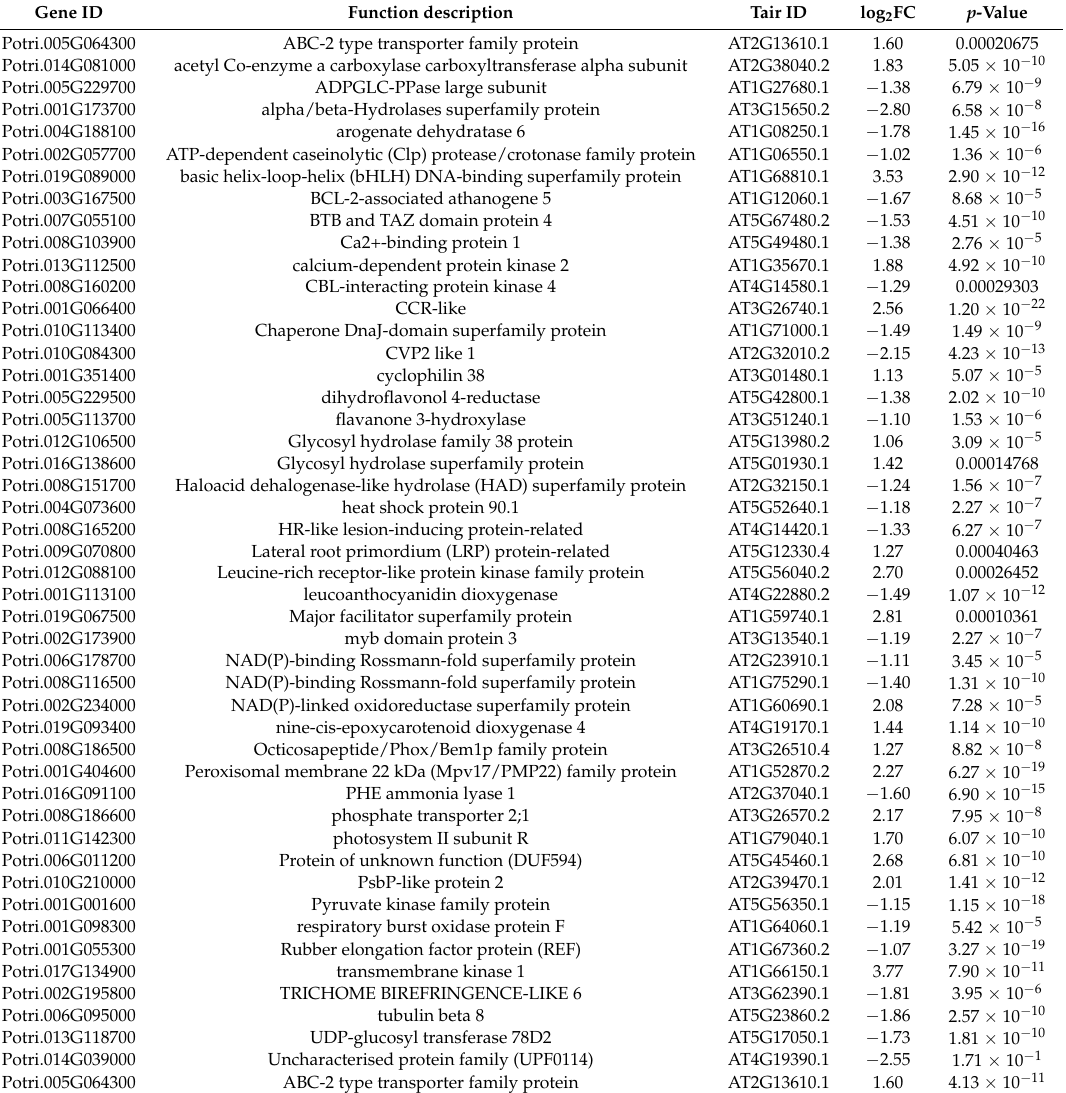
Table 2. Differentially expressed genes in transgenic poplar under non-salt